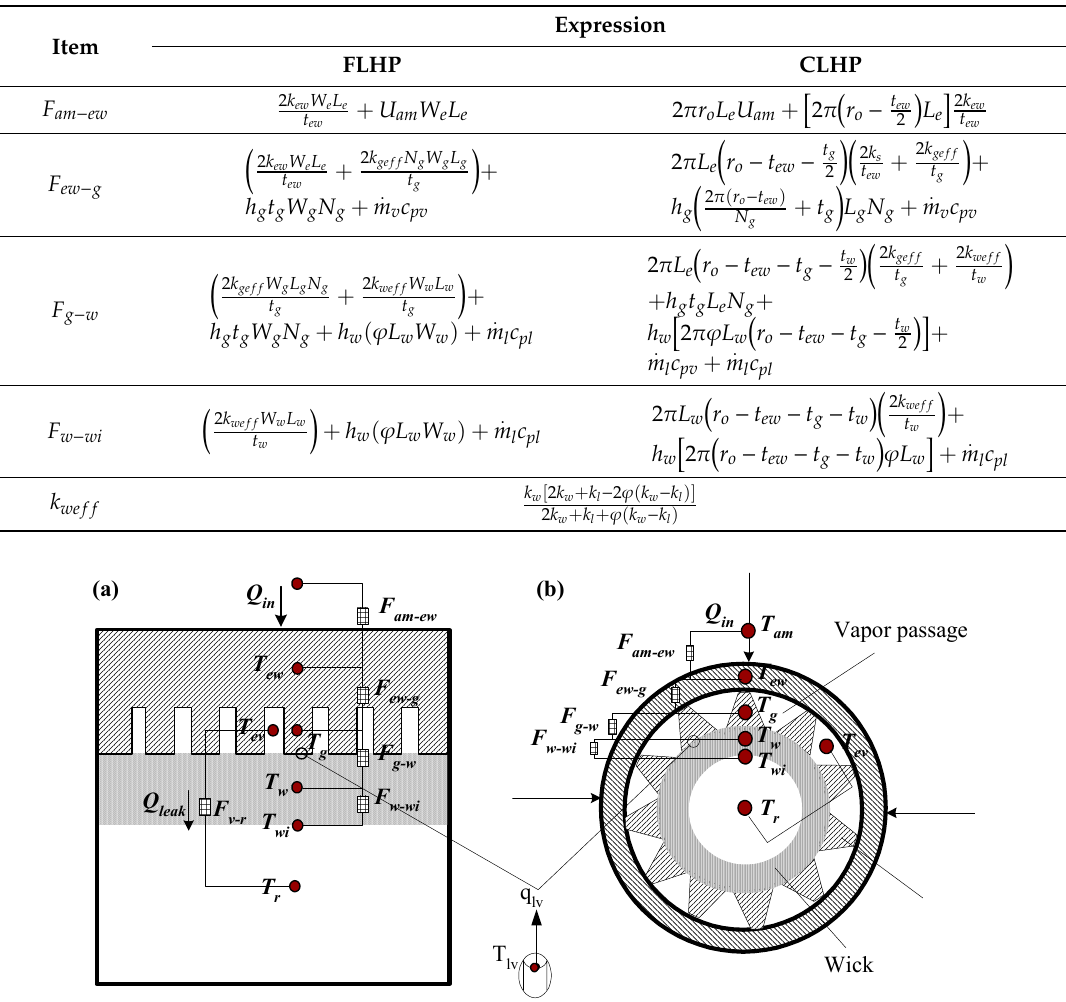
Table 1. Thermal conductance values concerning the analytical model of an LHP.